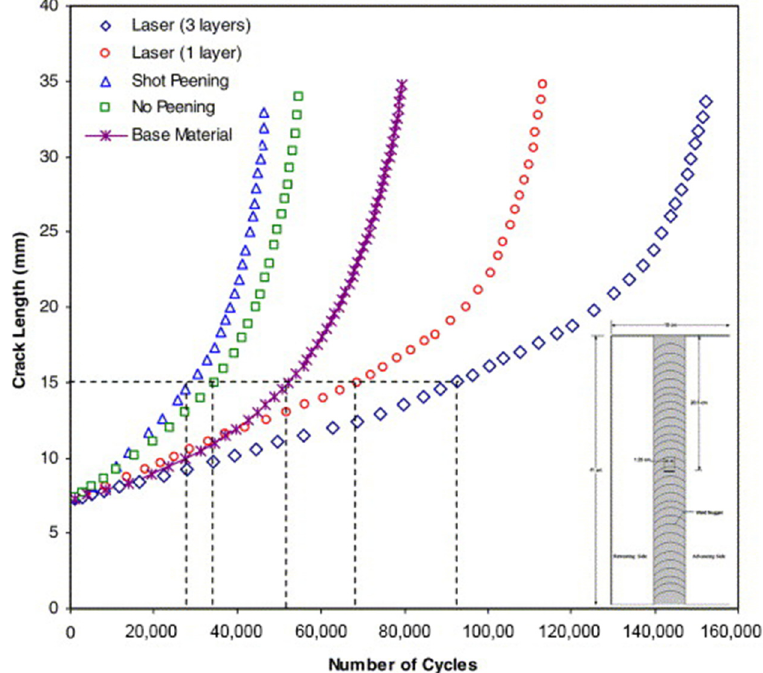
Figure 12. Fatigue growth data for FSW 7075-T7351 [85].